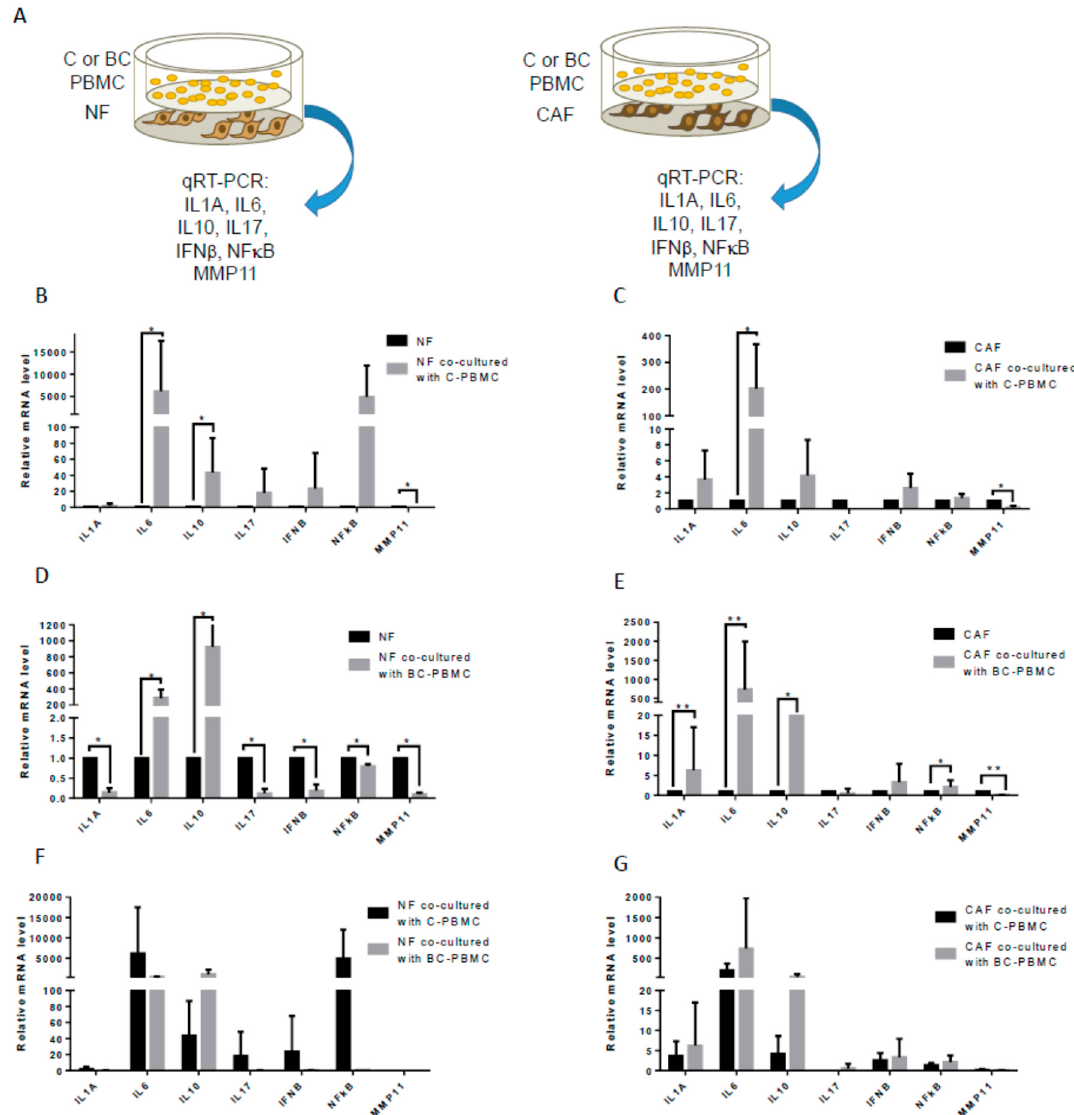
Figure 4. Inflammatory profile of breast cancer cell lines and fibroblasts after co-culture with PBMC. Scheme of experimental design ( A ). Gene expression of IL1A, IL6, IL10, IL17, IFN β , NFkB, and MMP11 in NF ( n = 6) ( B ) and CAF ( n = 6) ( C ) after co-culture with PBMC from healthy women (controls, C-PBMC). Gene expression of IL1A, IL6, IL10, IL17, IFN β , NFkB, and MMP11 in NF ( n = 6) ( D ) and CAF ( n = 24) ( E ) after co-culture with PBMC from breast cancer patients. Comparative of IL1A, IL6, IL10, IL17, IFN β , NFkB, and MMP11 gene expression in NF ( F ) and CAF ( G ) after co-culture with C-PBMC or BC-PBMC. Data represent the mean ± SD. (* p ≤ 0.05; ** p ≤ 0.01). Results of the qRT-PCR data were represented as fold expression.